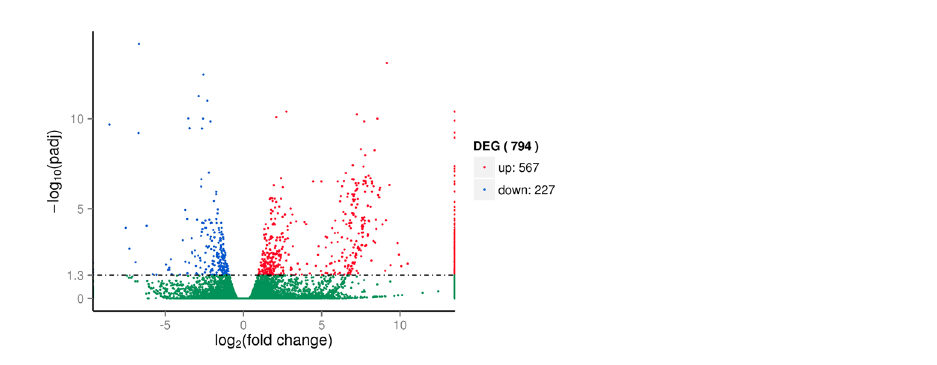
Figure 2. Analysis of differentially expressed unigenes in YYD (YY drought-stressed) vs. YYC (YY control).